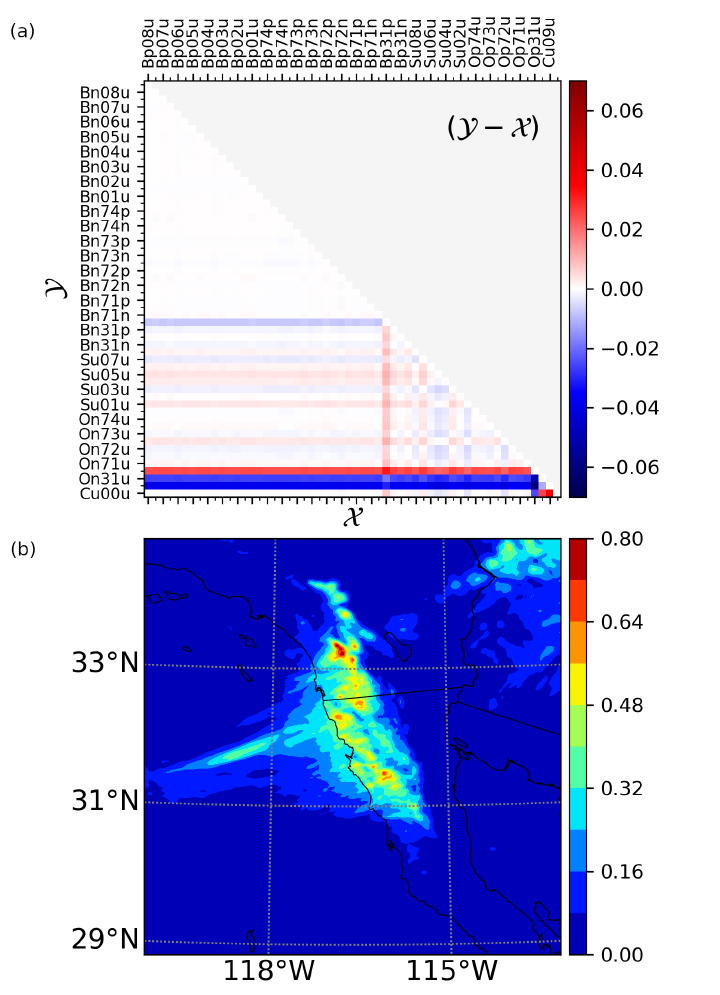
Figure 9. Overall bias ( a ) and standard deviation ( b ) of all members for precipitation in mm/h. Valid for the simulation period starting at 00Z on 27 February